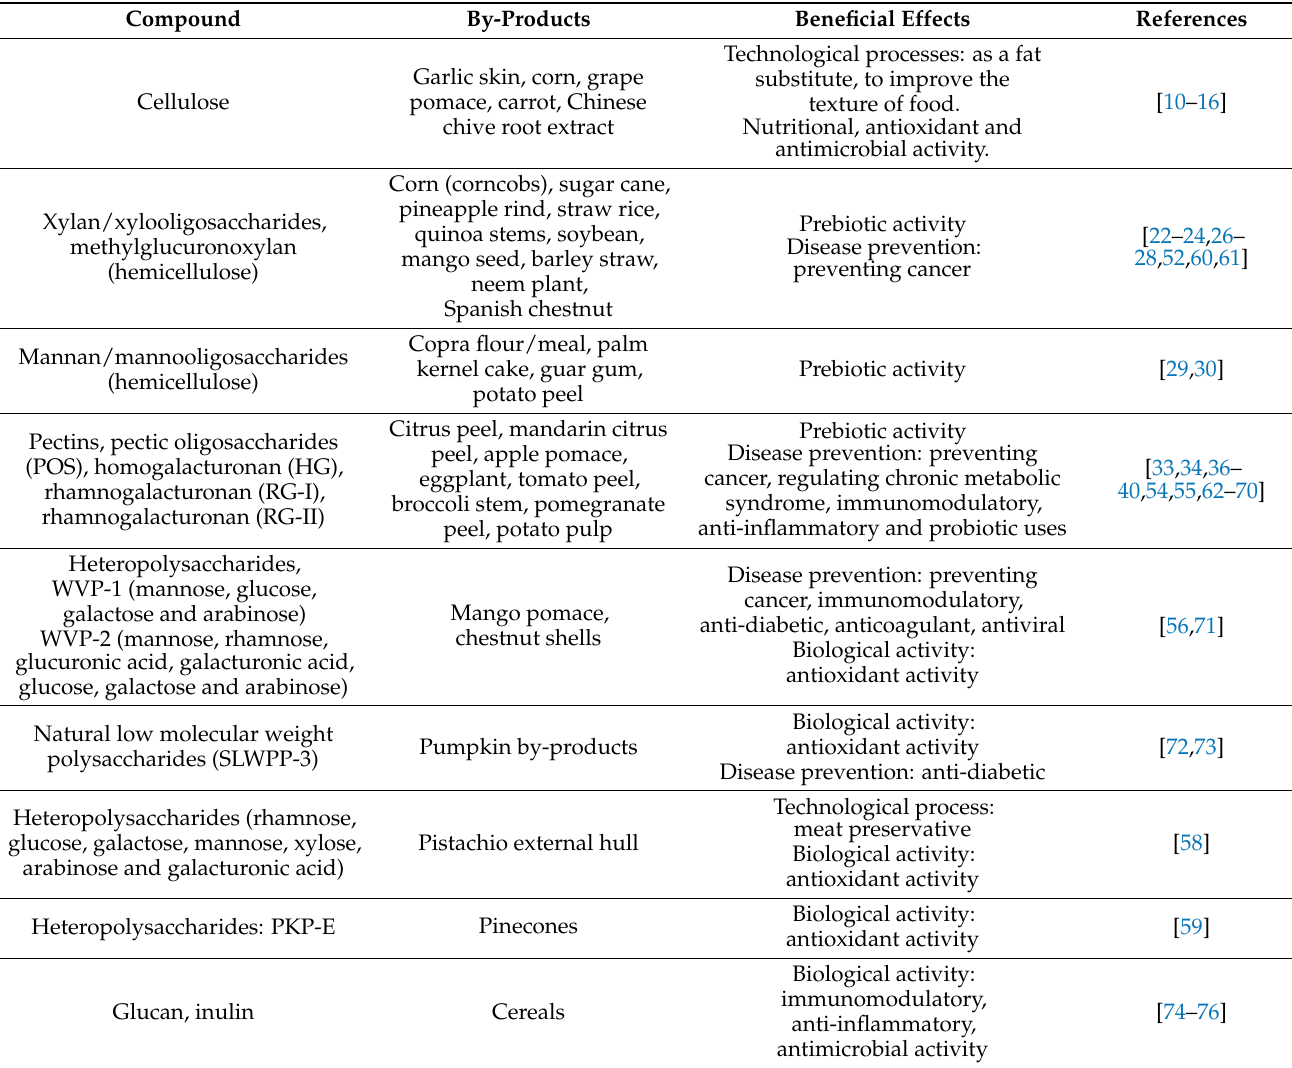
Table 1. Summary of applications of polysaccharides from by-products in the food